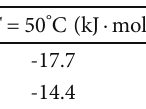
Table 4: Thermodynamic state variables for the adsorption of Ni(II) and Co(II) onto HSU331 in a single-component system (metal ion :ligand ratio of